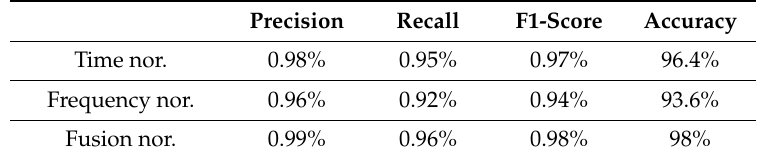
Table 6. Performance comparison analysis using each normalization method.